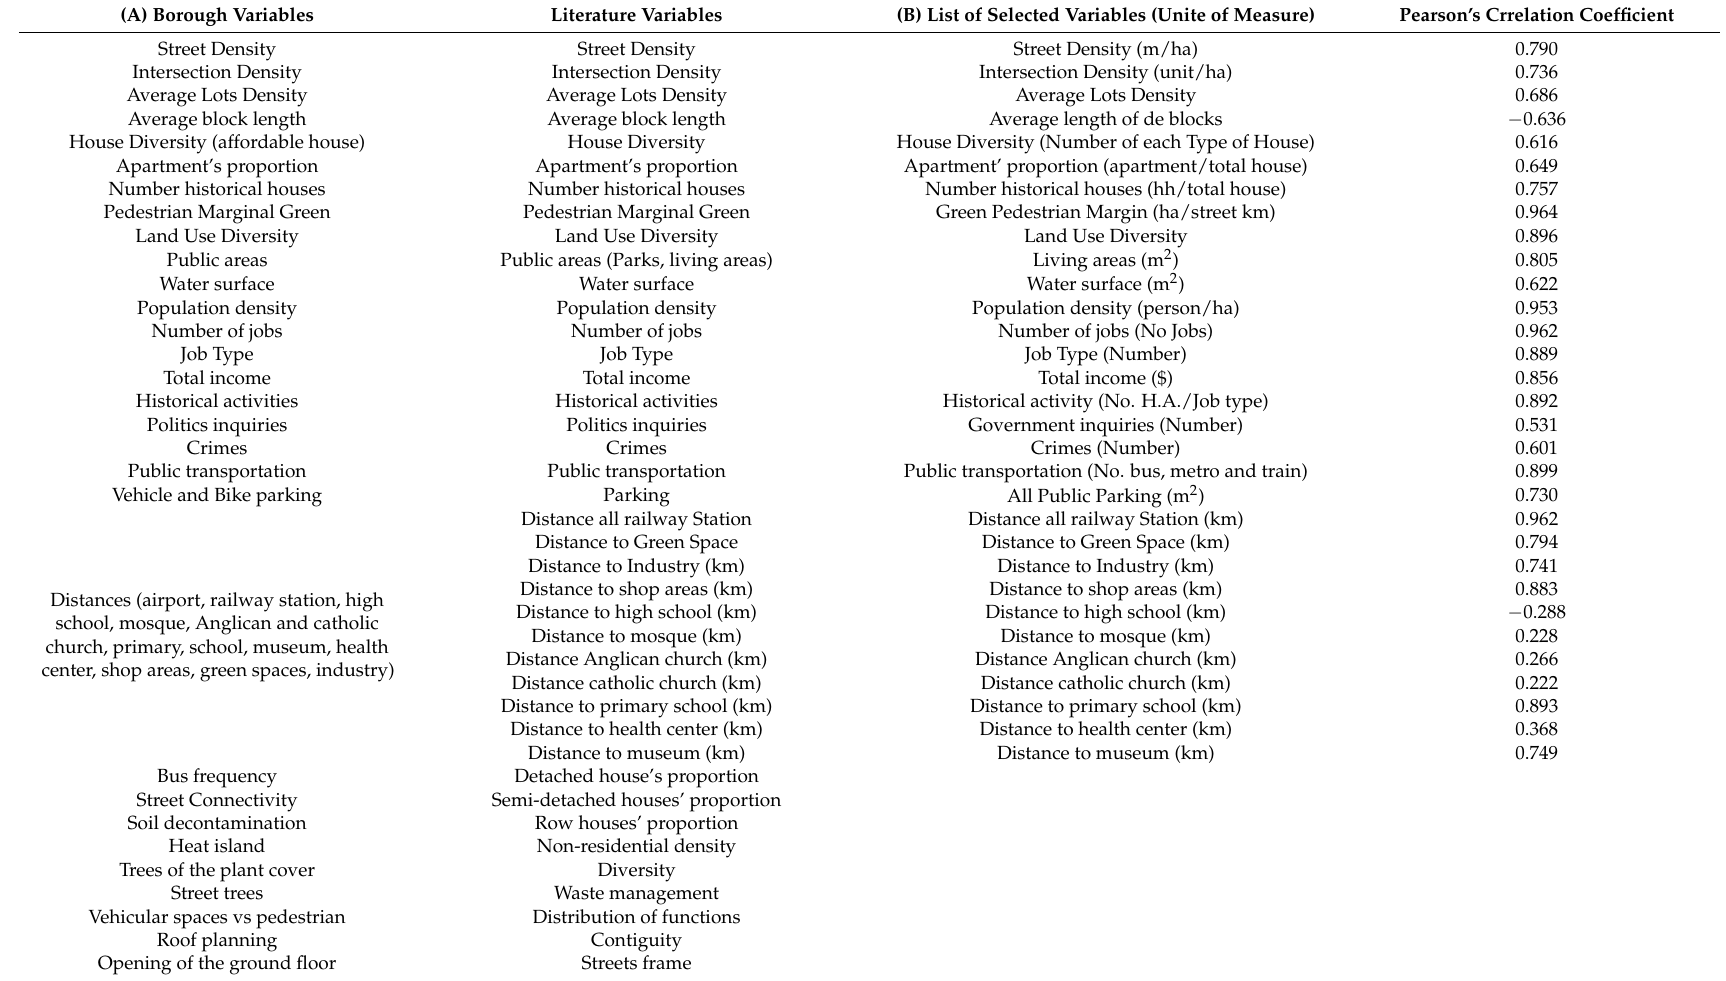
Table 3. Independent variables of the boroughs and from the